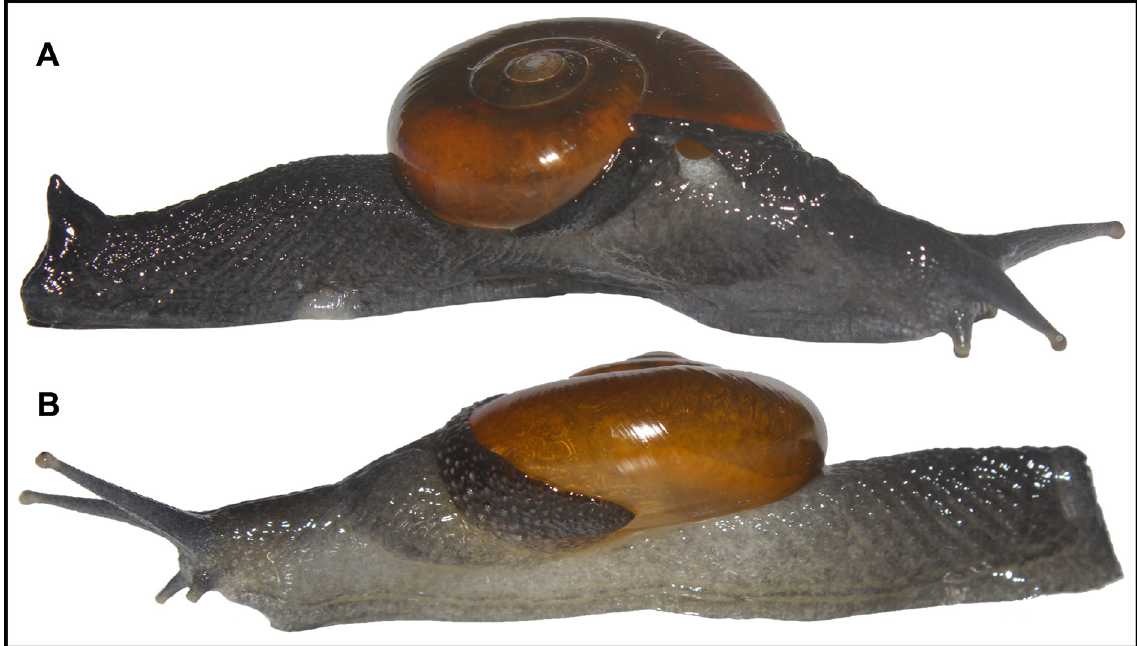
Fig. 6. Live individuals of Varadia amboliensis Bhosale, Thackeray, Muley & Raheem gen. et sp. nov. from Hiranyakeshi Temple, Amboli, showing shell lobes in retracted state. A . Right lateral view. B . Left lateral view. Note that the caudal horn is extended in A and fully retracted in